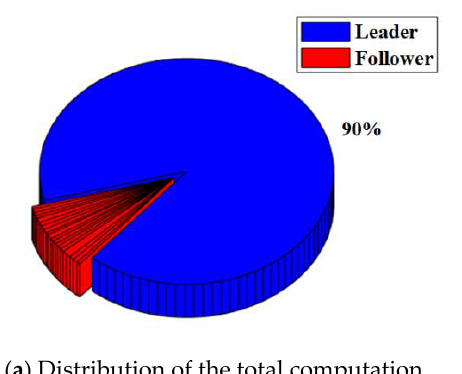
Figure 11. Resource occupation of the PBFT algorithm with malicious nodes.